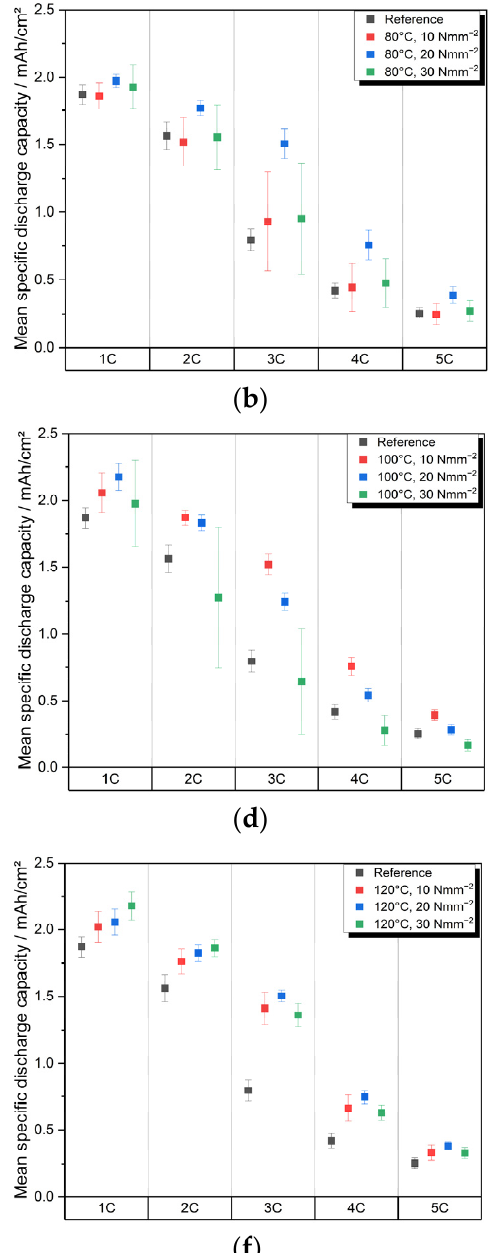
Figure 5. Mean specific discharge capacity of one compartment cells with cathode–separator lami- nates produced at lamination temperatures of 80 °C, 100 °C, 120 °C and lamination pressure of 10 Nmm − 2 , 20 Nmm − 2 , 30 Nmm − 2 ; mean specific discharge capacity of none laminated one compartment cells used as reference; ( a , c , e ) results of cycling tests for lamination temperatures of 80 °C, 100 °C, 120 °C; ( b , d , f ) results of C-rate tests performed after 300 cycles for lamination temperatures of 80 °C, 100 °C, 120 °C.